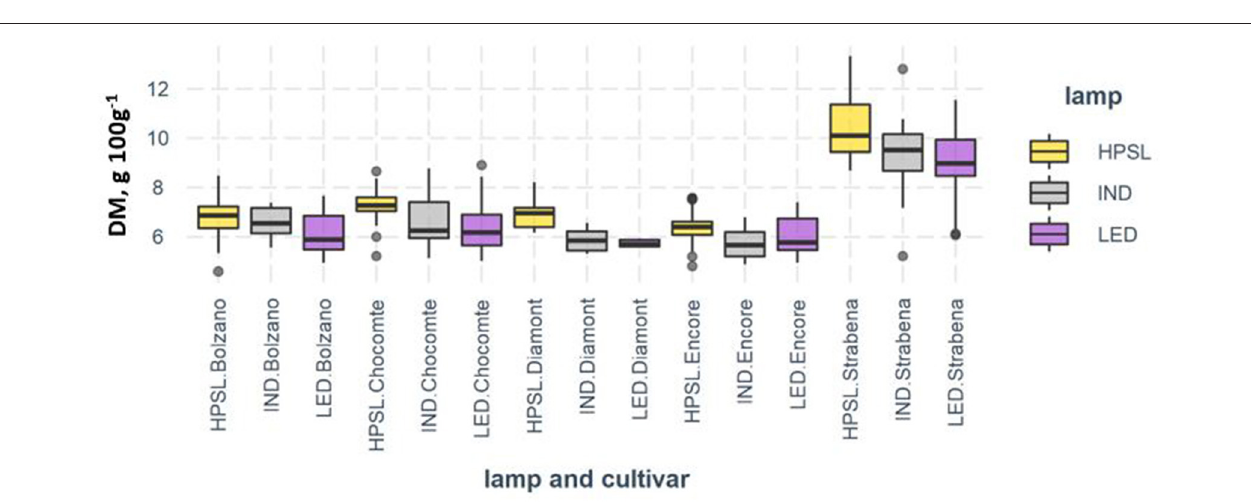
FIGURE 5 | Dry matter (g 100 g − 1 ) of tomato fruits grown under different supplemental light